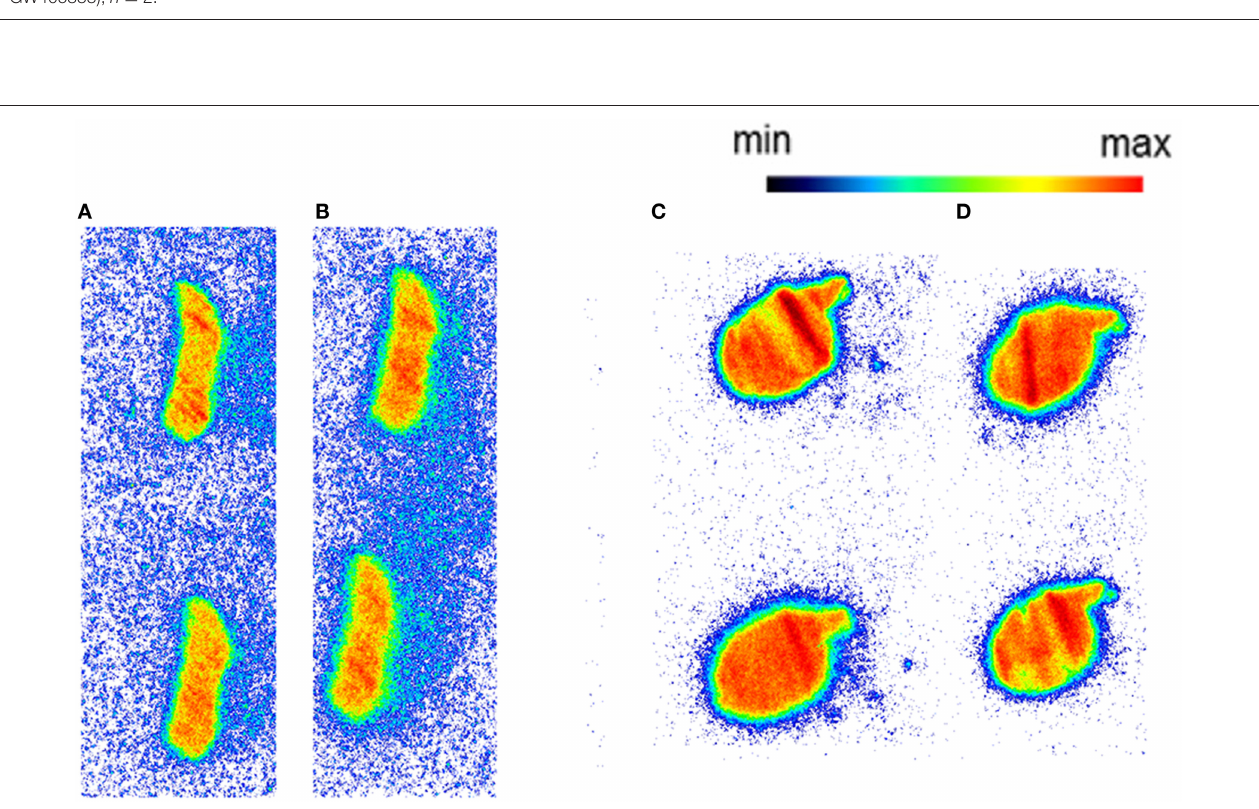
FIGURE 3 | The autoradiography results obtained with 5 nM [ 11 C]AAT-778 using spleen tissue sections. (A) Mouse spleen under baseline condition; (B) Mouse spleen under blockade conditions (10 µ M GW405833); (C) Rat spleen under baseline conditions; (D) Rat spleen under blockade conditions (10 µ M GW405833); n = 2.